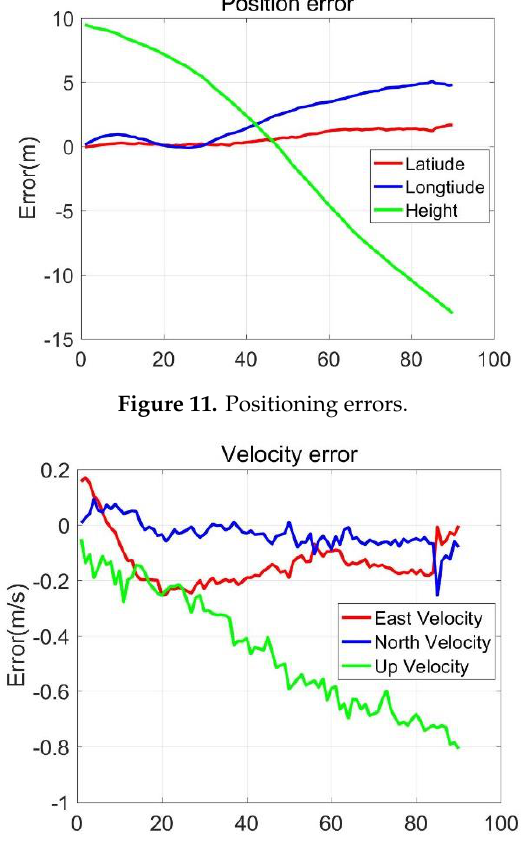
Figure 12. Velocity errors. Figure 12. Velocity